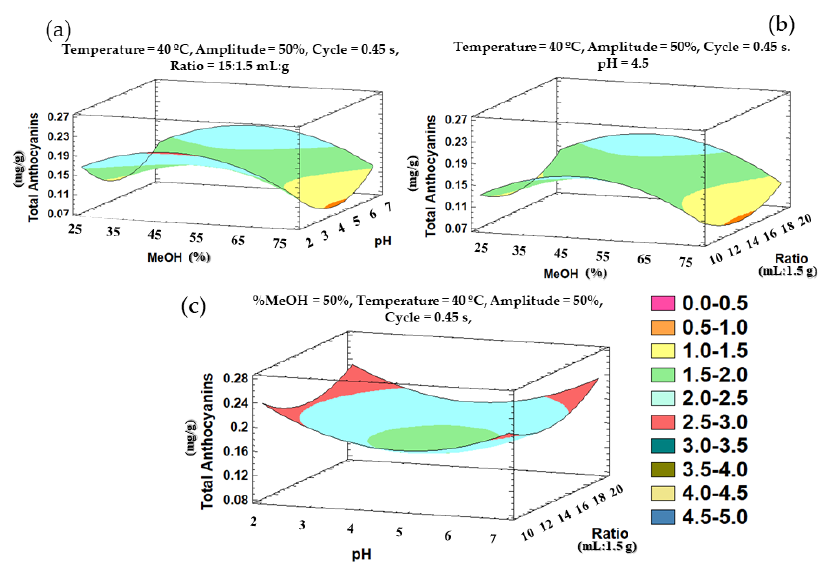
Figure 6. Three-dimensional surface plots representing the recovery of total anthocyanins according to a Box – Behnken design and depending on the following influential variables on the